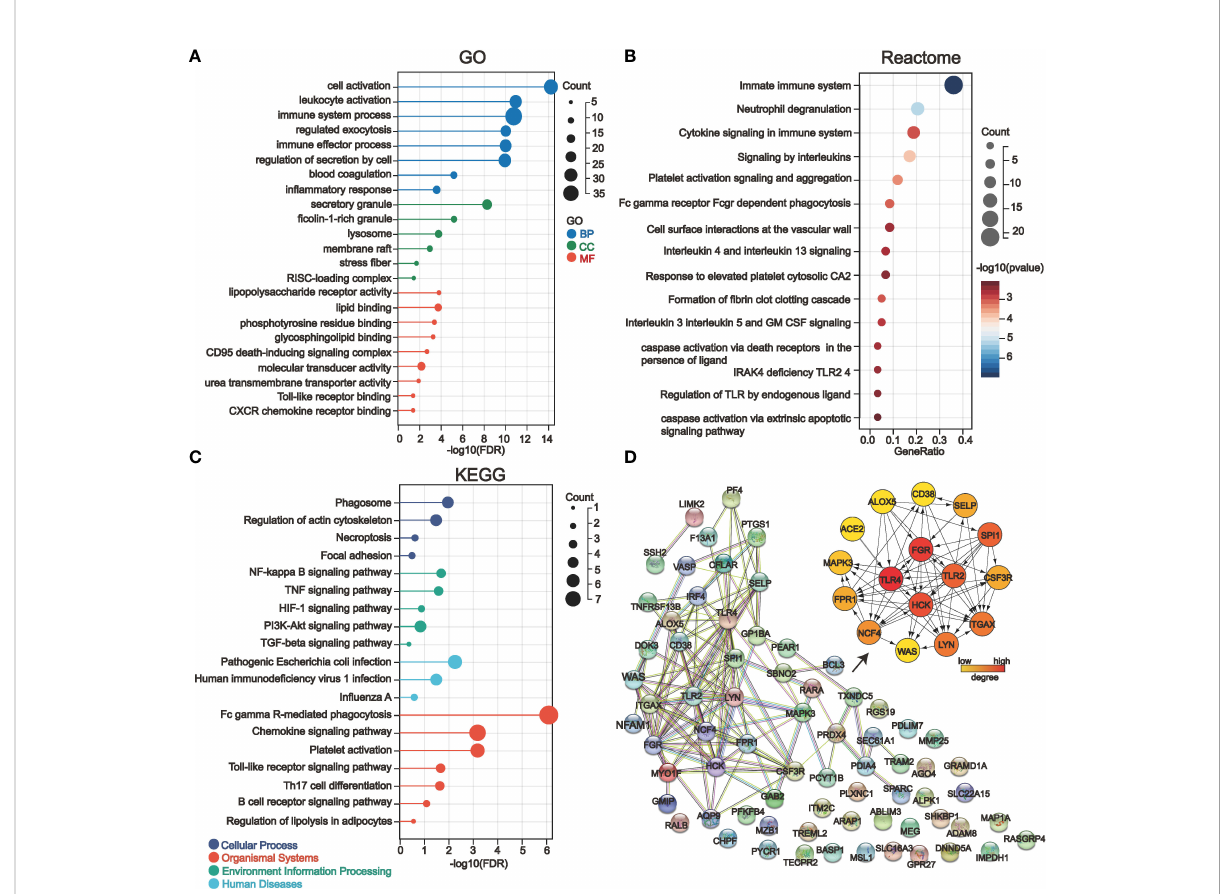
FIGURE 4 Gene enrichment analysis and protein-protein interaction network (PPI) analysis of 71 key genes in severe COVID-19 renal injury. (A – C) GO (A) , Reactome (B) , and KEGG (C) enrichment analysis of COVID-19 renal injury-related genes. (D) The PPI network of COVID-19 renal injury-related genes was constructed by the STRING database, and the hub genes in the network were further screened by the cytohubba plugin of cytoscape